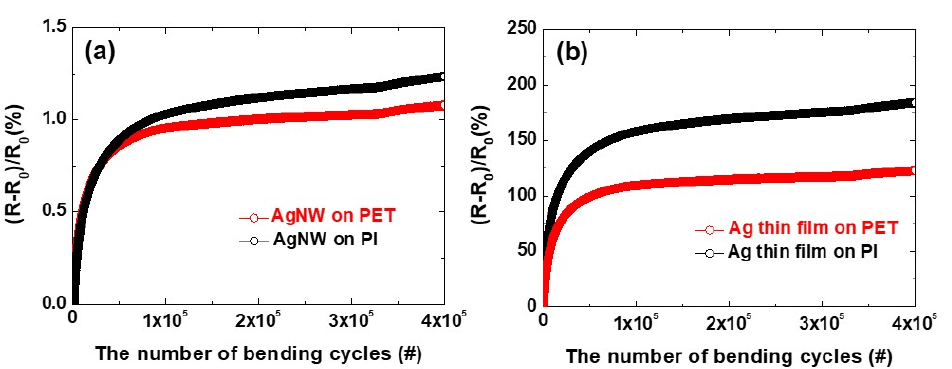
Figure 1. Normalized resistance change under cyclic bending of ( a ) Ag nanowire electrodes and ( b ) Ag thin films on PI and PET substrates. ( b ) Ag thin films on PI and PET